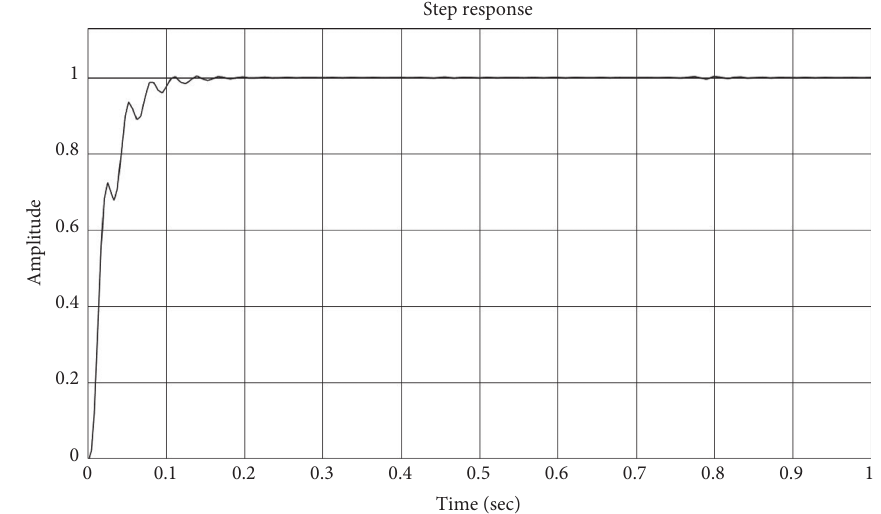
Figure 10: Step response curve of hydraulic synchronous system.